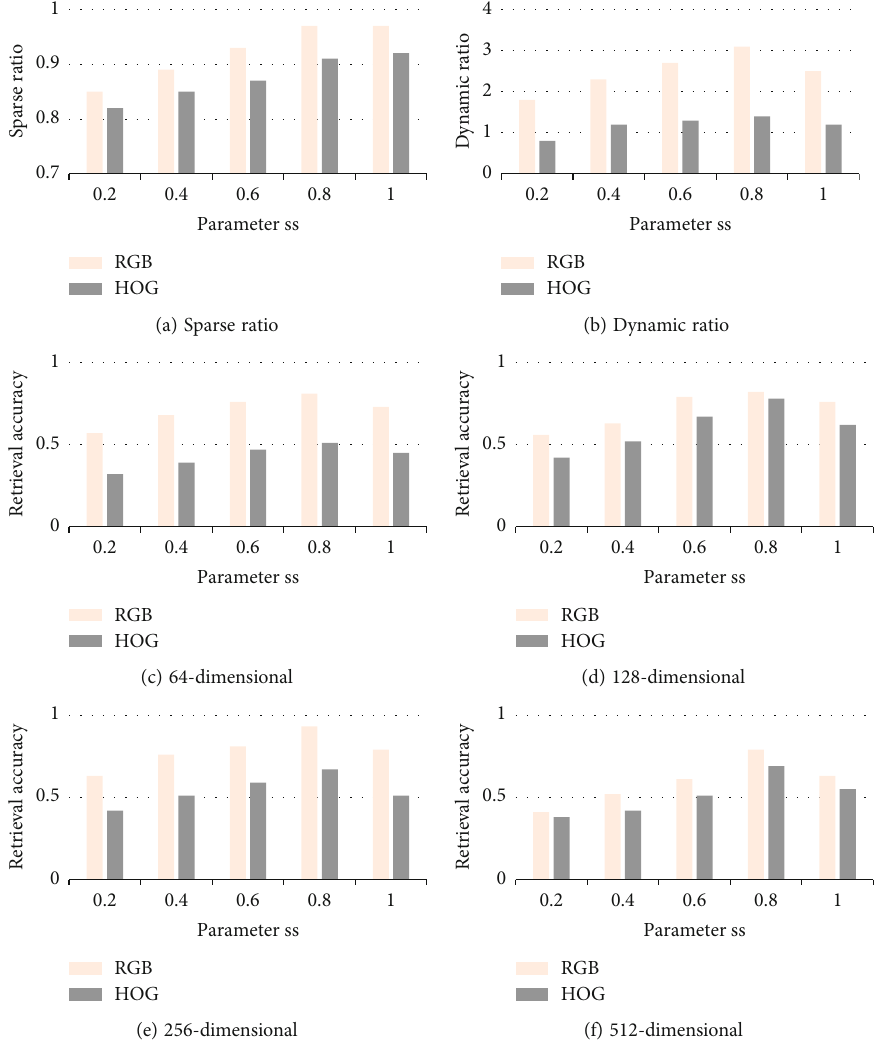
Figure 4: Experimental results under di ff erent parameters